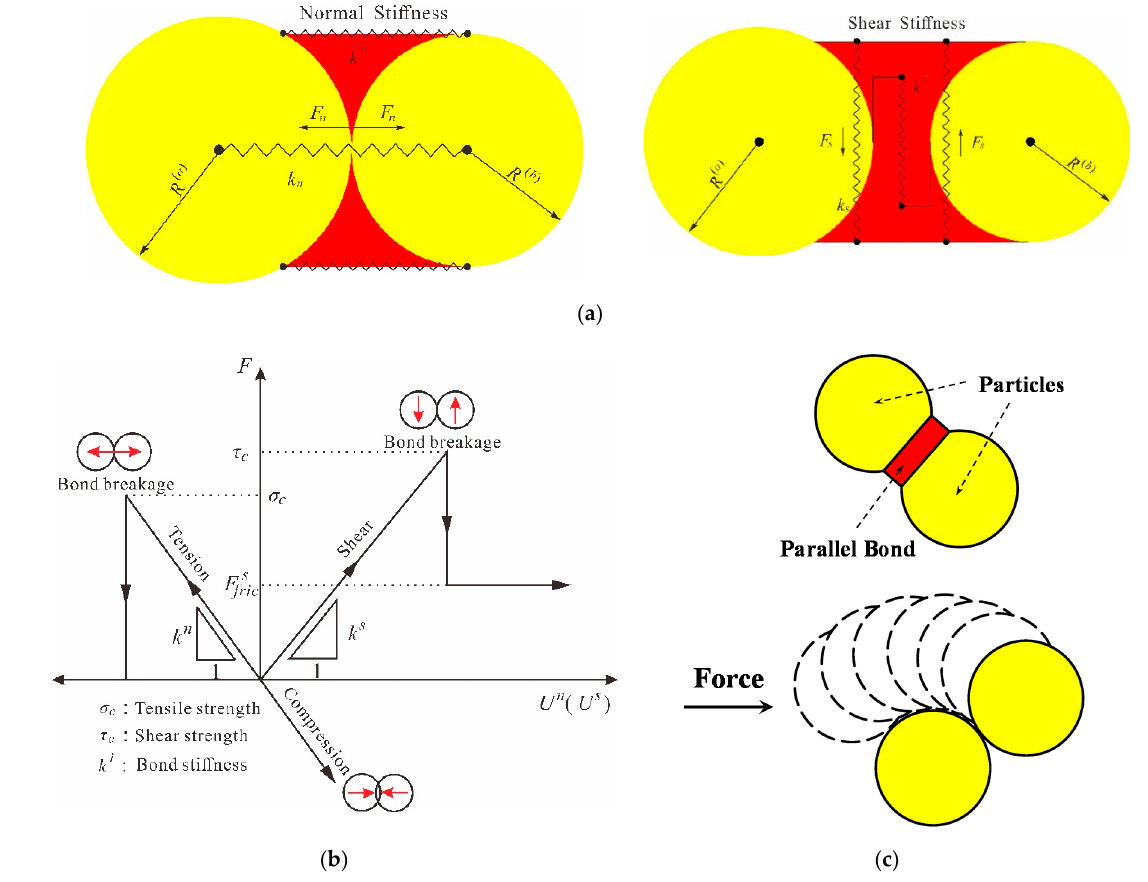
Figure 1. Schematic diagram of the Parallel-Bond contact in PFC2D (modified from Itasca Consulting Group, Inc.: Minneapolis, MN, USA [48]): ( a ) conceptual models; ( b ) the deformation and failure mechanisms; and ( c ) the failure mode.